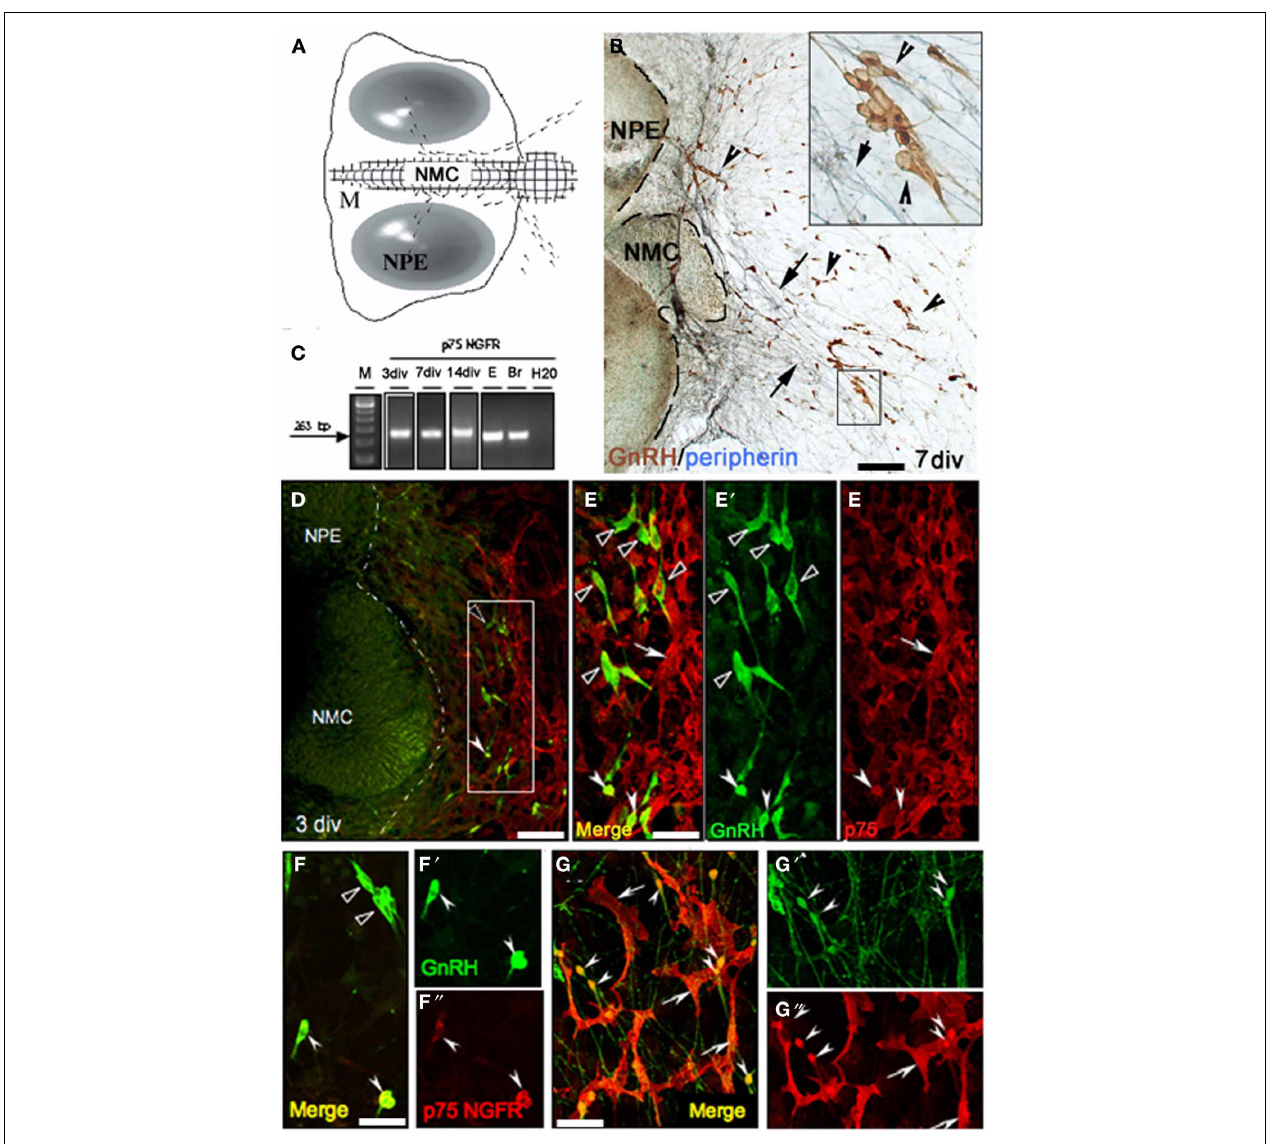
FIGURE 5 | P75NGFR expression in nasal explants mimics expression invivo .(A) SchematicofnasalexplantshowingthemigrationofGnRHneurons (blackdots) acrossthemaintissuemass(M) fromthenasalpit/epithelial region (NPE) to the nasal midline cartilage (NMC), and then into the periphery of the explant. (B) Double immunocytochemistry showing GnRH neurons (brown, arrowheads)andperipherinfibers(blue,arrows)ona7divnasalexplant.Atthis stage the majority of GnRH neurons have migrated off the main tissue mass into the periphery along peripherin-immunoreactive axons (see insert). (C) Gel documentation of PCR products using specific primers for p75NGFR on single GnRH cell at 3, 7, 14div, E17.5 head (E) and adult brain (Br). A band of expected size(263bp)wasdetectedinGnRHcellsinnasalexplantsatall3ages.Noband was detected in water. (D,E) Double immunofluorescence using antibodies against GnRH (green) and p75NGFR (red) at 3div showed that the majority of